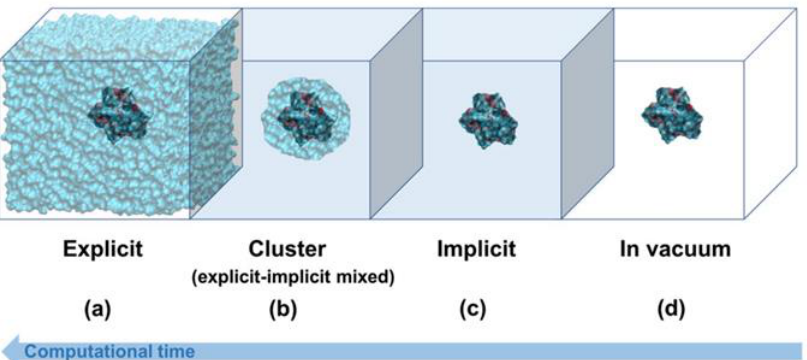
Figure 2. Schematic representation of solvent models used to study the effect on the complex. Three different solvation models—implicit (or continuum), cluster/continuum (or hybrid implicit/explicit), and fully explicit ( a – c )—can be used to simulate complex interactions and compared with those in vacuum environments ( d ). These simulations are arranged according to the computational time involved. Reproduced from [116] with permission from Springer